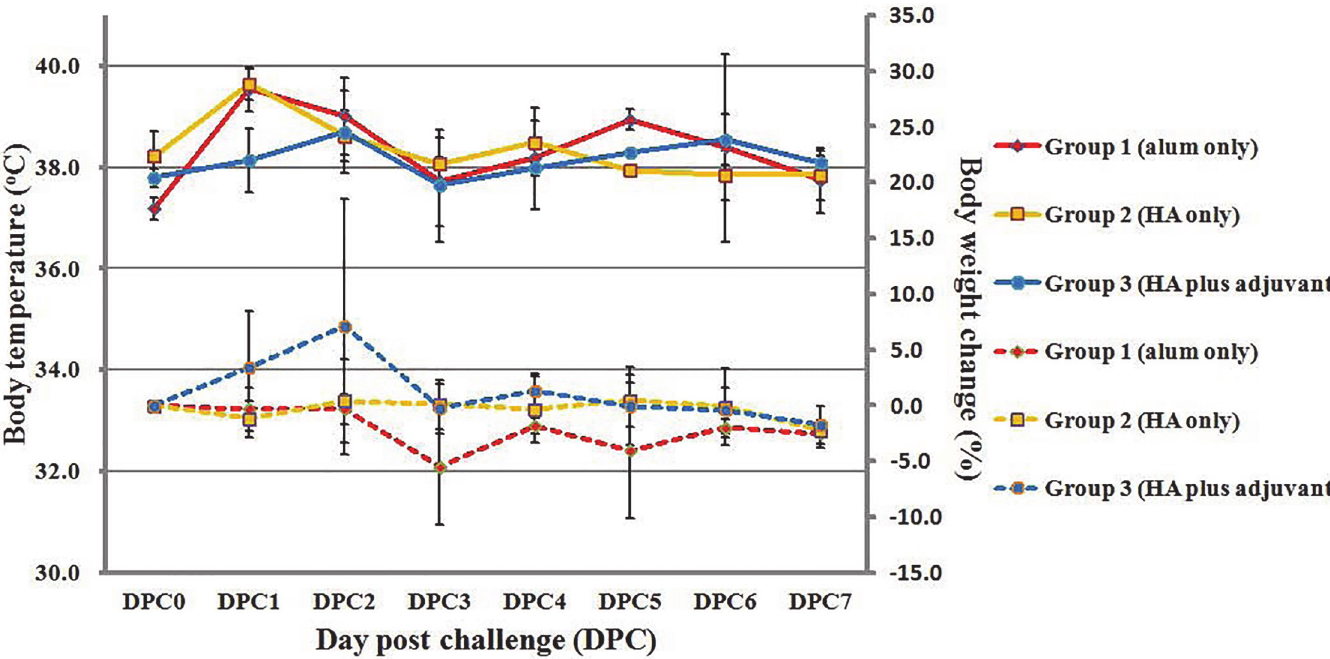
Fig 2. Changes in body temperatures and weights in ferrets within 7 days post challenge (DPC) with wild-type influenza H7N9 virus. The solid and dotted lines represent changes of body temperatures and weights, respectively. Data are expressed as a percentage of the baseline and the vertical bars represent group standard deviations (mean ± SD). 0 – 3 DPC: 4 ferrets for each group; 4 – 7 DPC: 2 ferrets for each